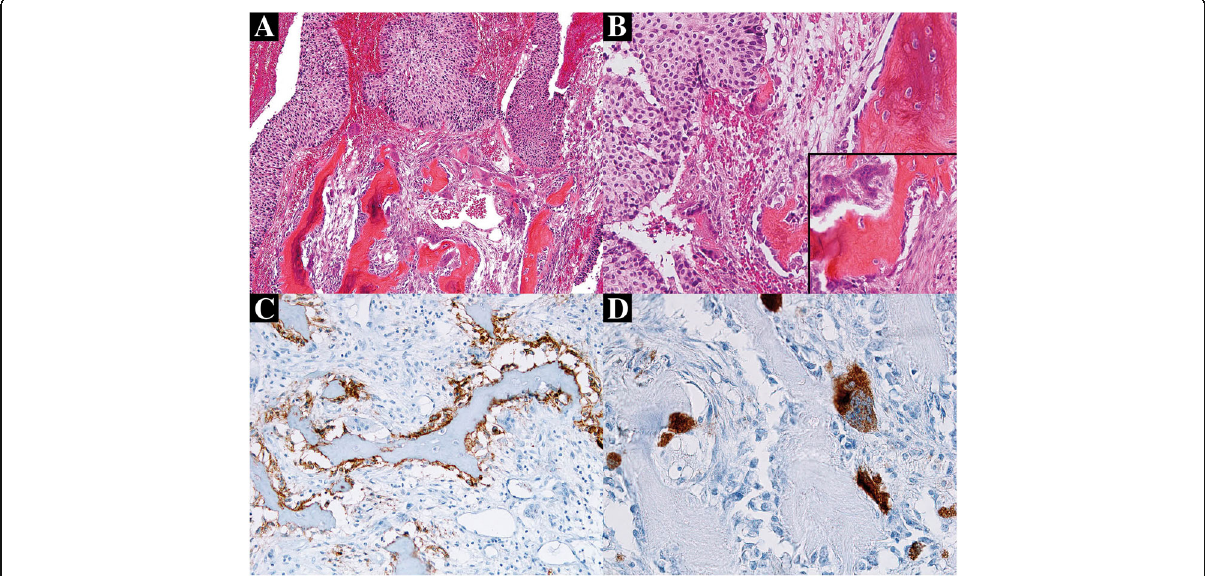
Fig. 1 Stromal osseous metaplasia in urothelial carcinoma of the bladder. a Tumor stroma containing multiple bone trabeculae of variable size, separated by loose fibrous connective tissue with osteoid seams (Hematoxylin and Eosin Stain × 200). b Osteoid and bone trabeculae outlined by large cells with abundant cytoplasm and multinucleated giant cells, corresponding respectively to osteoblasts and osteoclasts. Transitional cell carcinomatous component is seen on the left. (Hematoxylin and Eosin Stain × 400). c Positive and diffuse membrane staining of osteoblasts with CD56 antibody. d Strong positive cytoplasmic staining pattern of osteoclasts with CD68